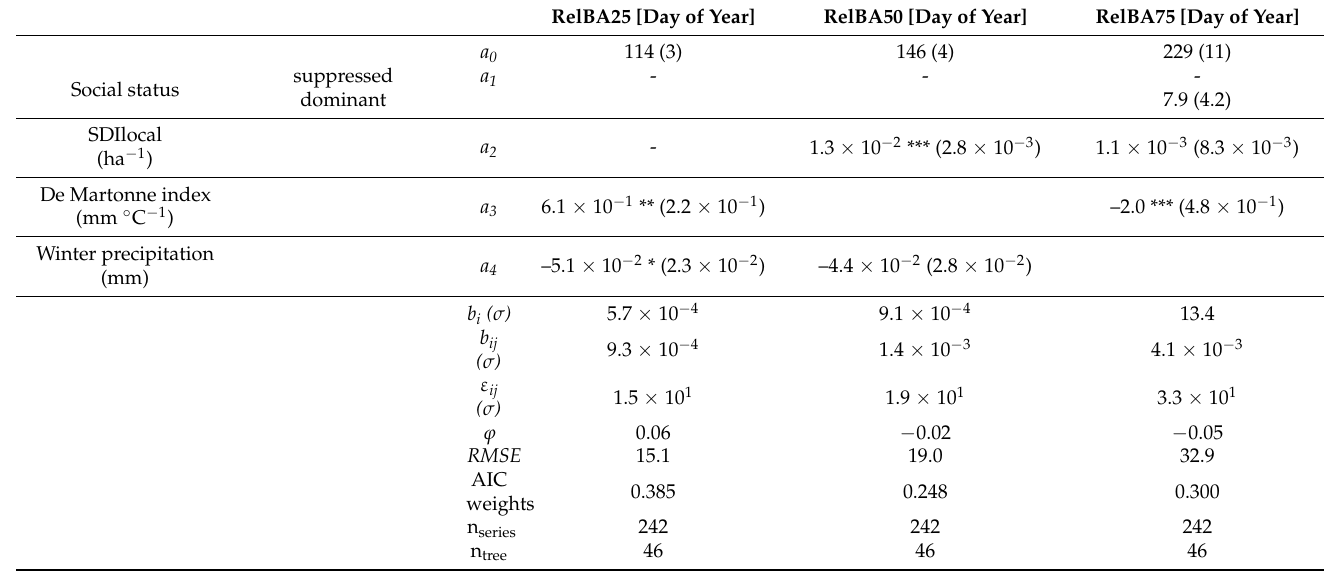
Table 4. Mixed-model statistics; effect of SocStat, SDIlocal, DeMart and PrecWint on intra-annual basal area growth. Numbers in brackets next to the regression coefficients represent the